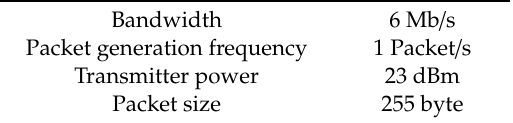
Table 3. Key operating parameters of the VANET segments.